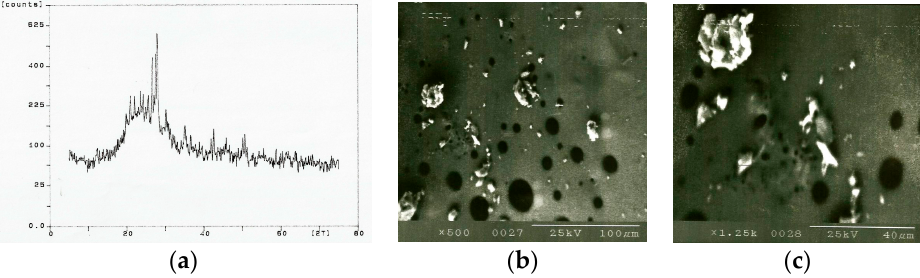
Figure 7. Sintered bond mix (20 wt. % BC, 20 wt. % FFF, and 60 wt. % BX) material sample: ( a ) X-ray diffraction pattern for 2 θ angles showing arbitrary counts (counts) versus 2 θ angles (2T) in degrees; ( b ) Scanning electron micrograph at 500× magnification; and ( c ) scanning electron image at 1250× magnification.